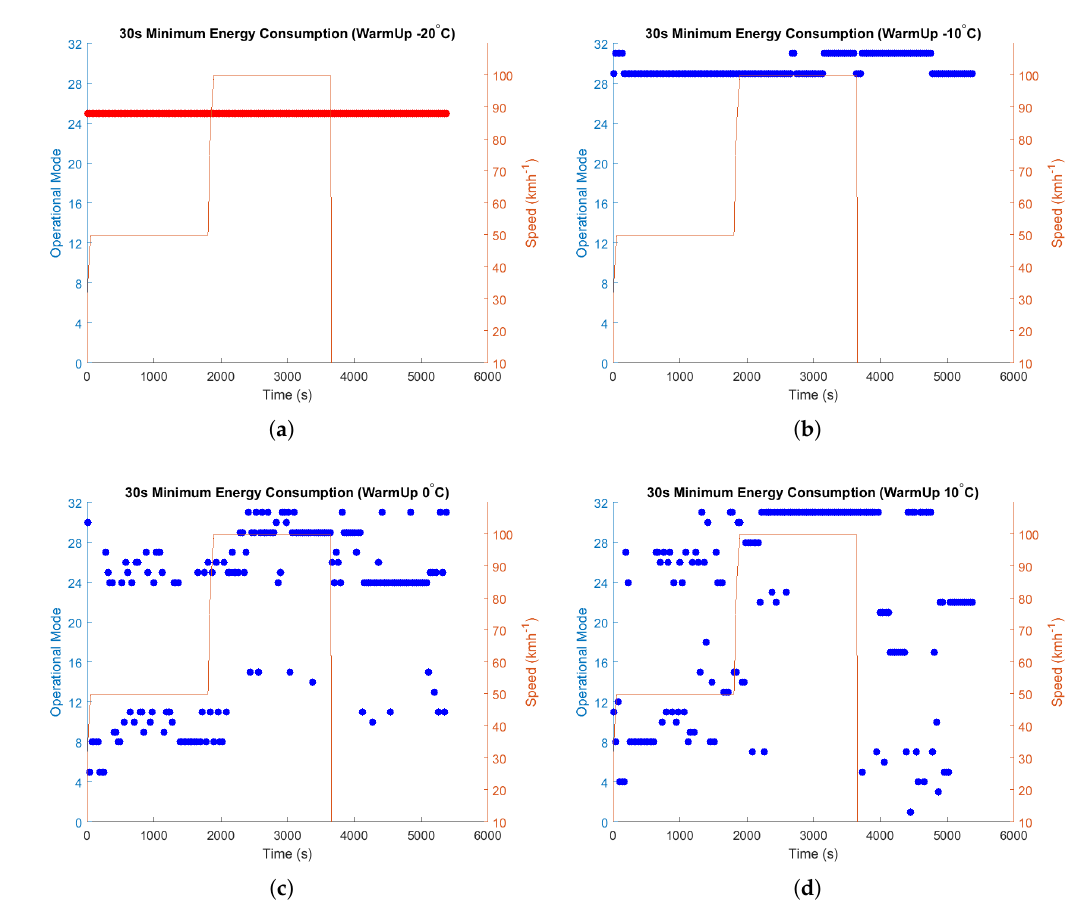
Figure 7. The best operational mode during 30 s intervals as a function of time is shown through the Warm up drive cycle over temperatures − 20 ◦ C ( a ), − 10 ◦ C ( b ), 0 ◦ C ( c ) and 10 ◦ C ( d ). Blue dots show the operational mode which used the least energy during that 30 s interval. This has been overlaid with the Warm up drive cycle. Red dots indicate when no operational mode met cabin target temperature, blue dots indicate multiple operational modes met cabin target temperature.